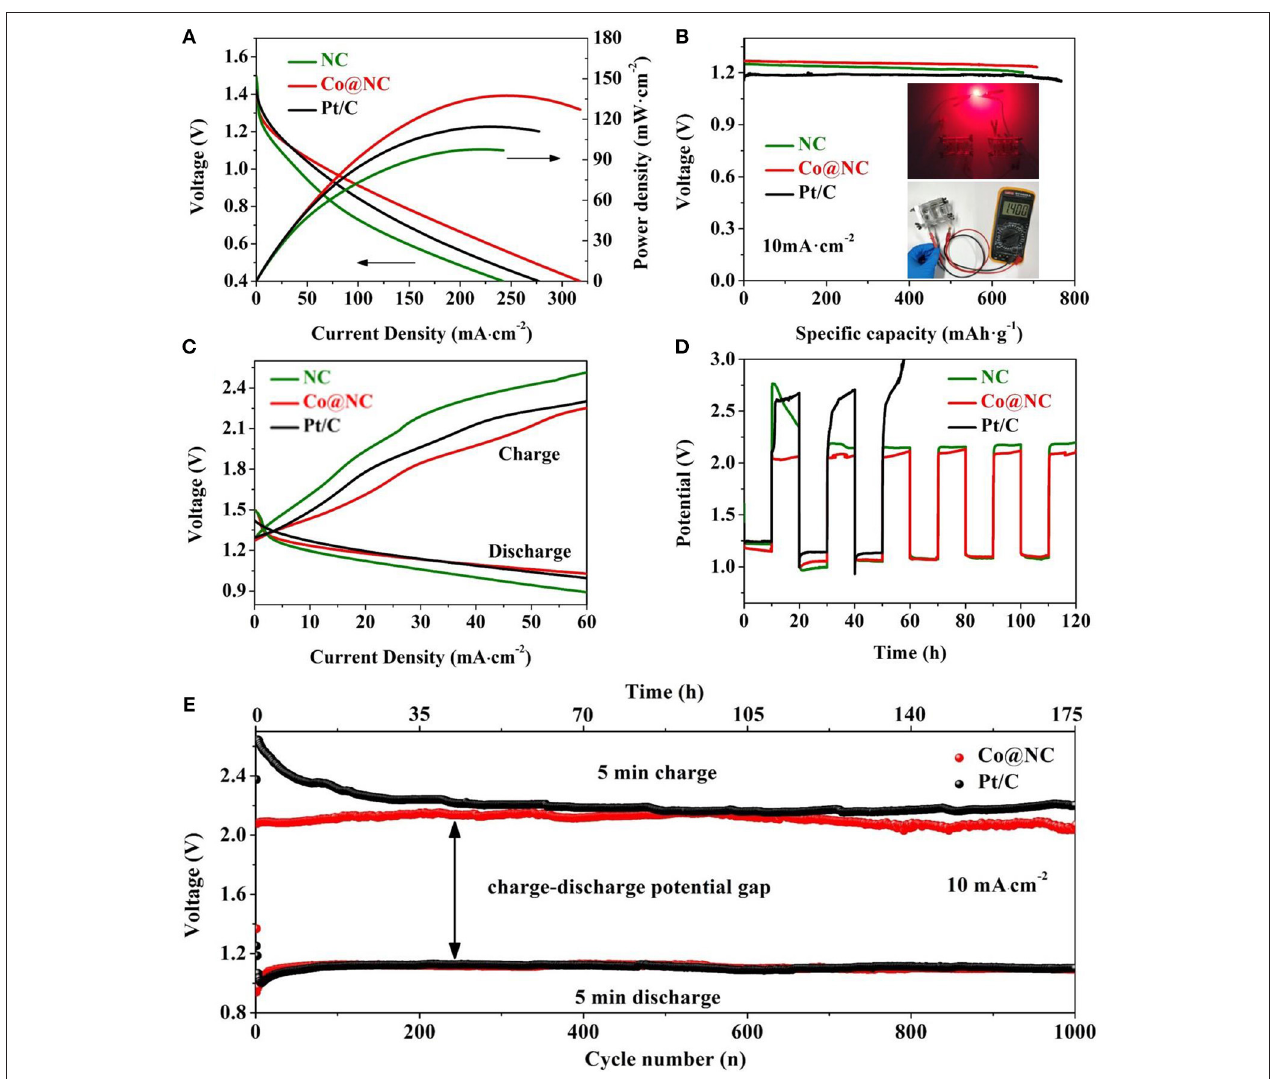
FIGURE 5 | (A) Discharge polarization curves and their corresponding power density curves. (B) Typical discharge curves of Co@NC, NC, and Pt/C based Zn-air batteries under continuous discharge until complete consumption of Zn. The illustrations are photograph of the assembled battery with an open-circuit voltage of 1.4V and red LED powered in series by two rechargeable Zn-air batteries. (C) Charge/discharge polarization curves of the Co@NC, NC, and Pt/C catalyst, respectively. (D) Galvanostatic charge/discharge test of Co@NC, NC, and Pt/C based Zn-air battery (current density: 10 mA · cm − 2 , cycle period: 20h). (E) Charge/discharge cycling curves of Co@NC-based battery (current density: 10 mA · cm − 2 , cycle period: